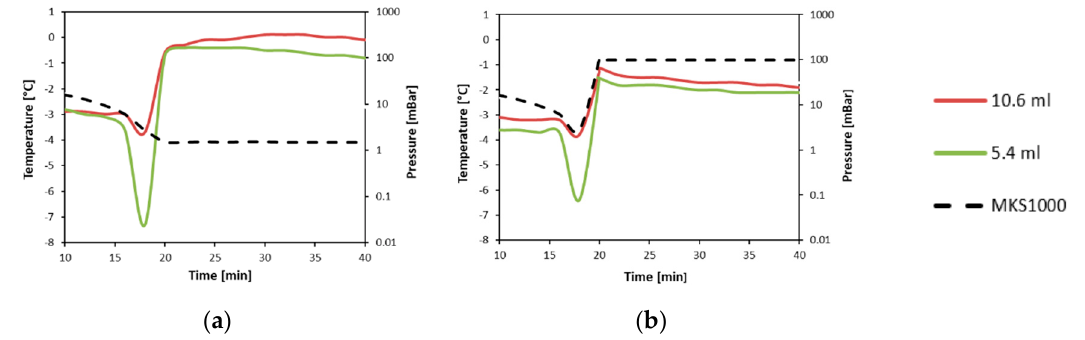
Figure A1. Product temperature for 5.4 mL and 10.6 mL fill volumes during the nucleation event ( a ) without and ( b ) with pressure increase to 100 mbar. Product temperature was measured with a thermocouple at the outside of the vial. The pressure was monitored by an MKS10 pressure probe.